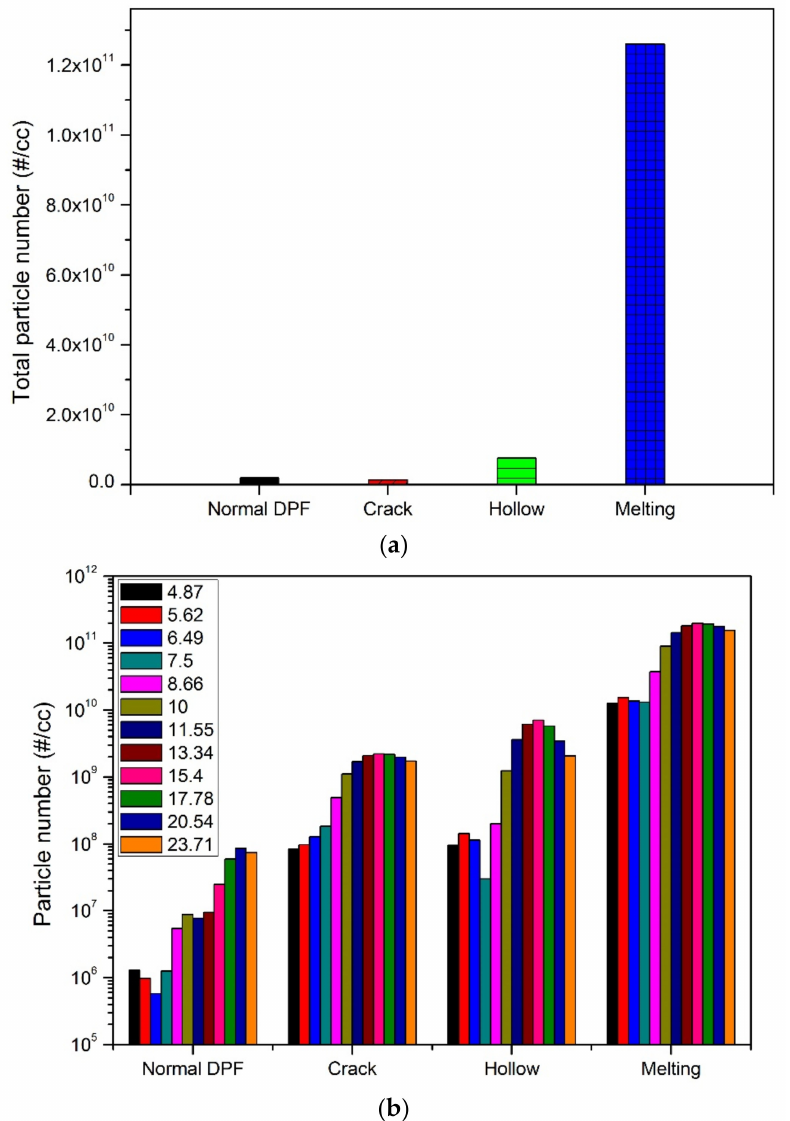
Figure 15. Comparison of particle number density for 4 types of DPF sample. ( a ) Total particle number. ( b ) Particle number with nano-sized of 23 nm or less (decimal